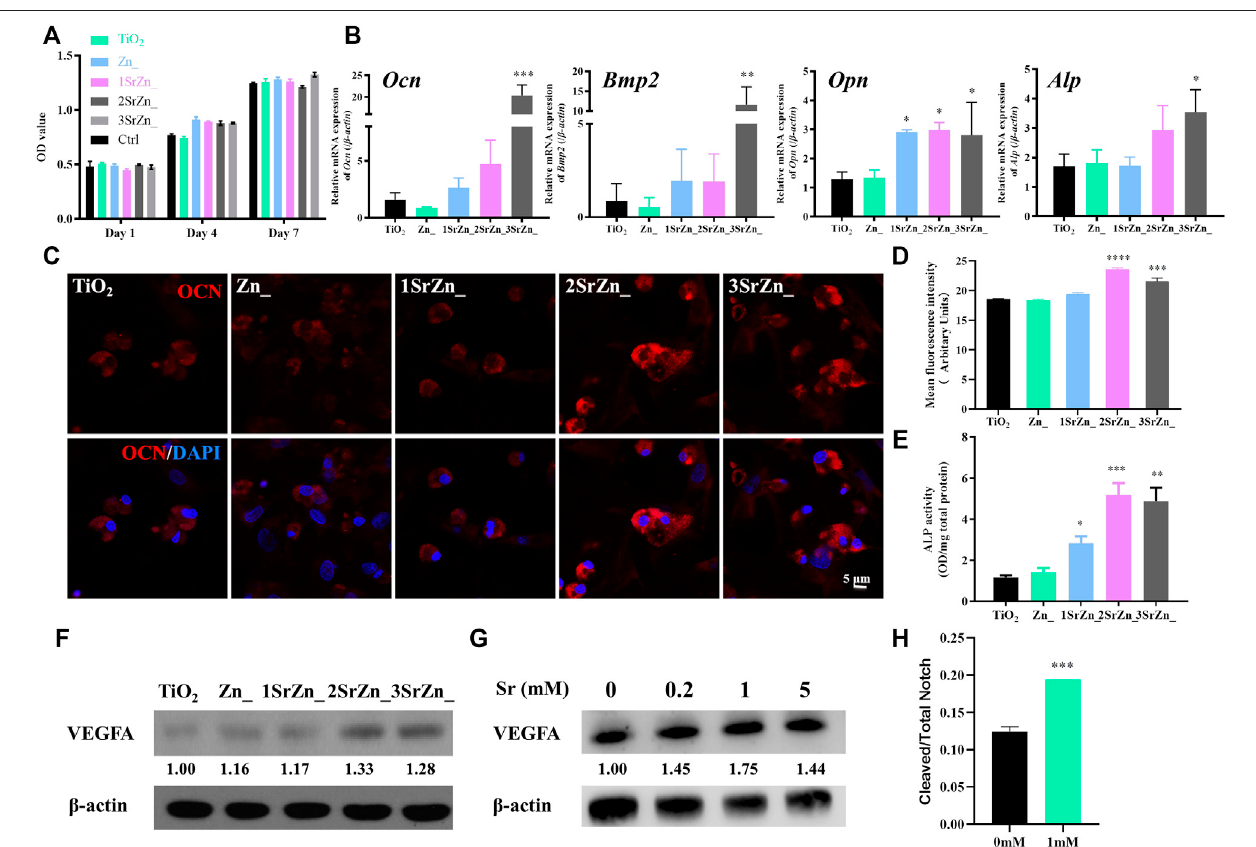
FIGURE4| TheosteogenicpotentialofOVXBMSCsontheSr-Zn-augmentedtitaniumsurfacesandthevasotropiceffectsofSr. (A) Cellproliferationactivityassay of the OVX BMSCs on different samples evaluated by CCK-8, with culture medium containing no sample as control. (B) Temporal expression of osteogenic-related genesofOVXBMSCsondifferentsurfacesat7 days,including Ocn , Opn , Bmp2 ,and Alp . (C) Immuno fl uorescenceassayofOCNexpressioninOVXBMSCsincubated onthecoatingswithananalysisof (D) mean fl uorescenceintensity. (E) ALPactivitytestofOVXBMSCsonsurfaces. (F) VEGFAexpressionofOVXBMSCsseeded onsamplesfor7 dayswastestedbyWesternblotwithquanti fi cation. (G) WesternblotdetectionandanalysisofVEGFAexpressioninHUVECstreatedwith0,0.2,1,and 5 mM Sr for 7 days. (H) The ratio of cleaved and total Notch of HUVECs after 1 h in 1 mM Sr-containing medium and control medium by ELISA ( n = 3, * p < 0.05, ** p